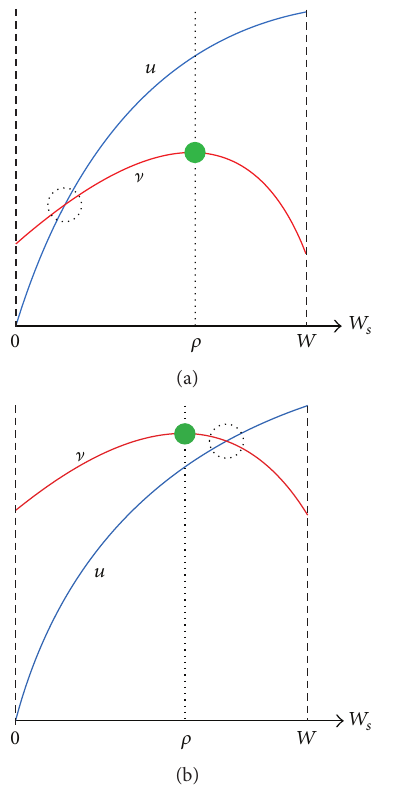
Figure 2: Illustration of the curves: 𝑢 and V .